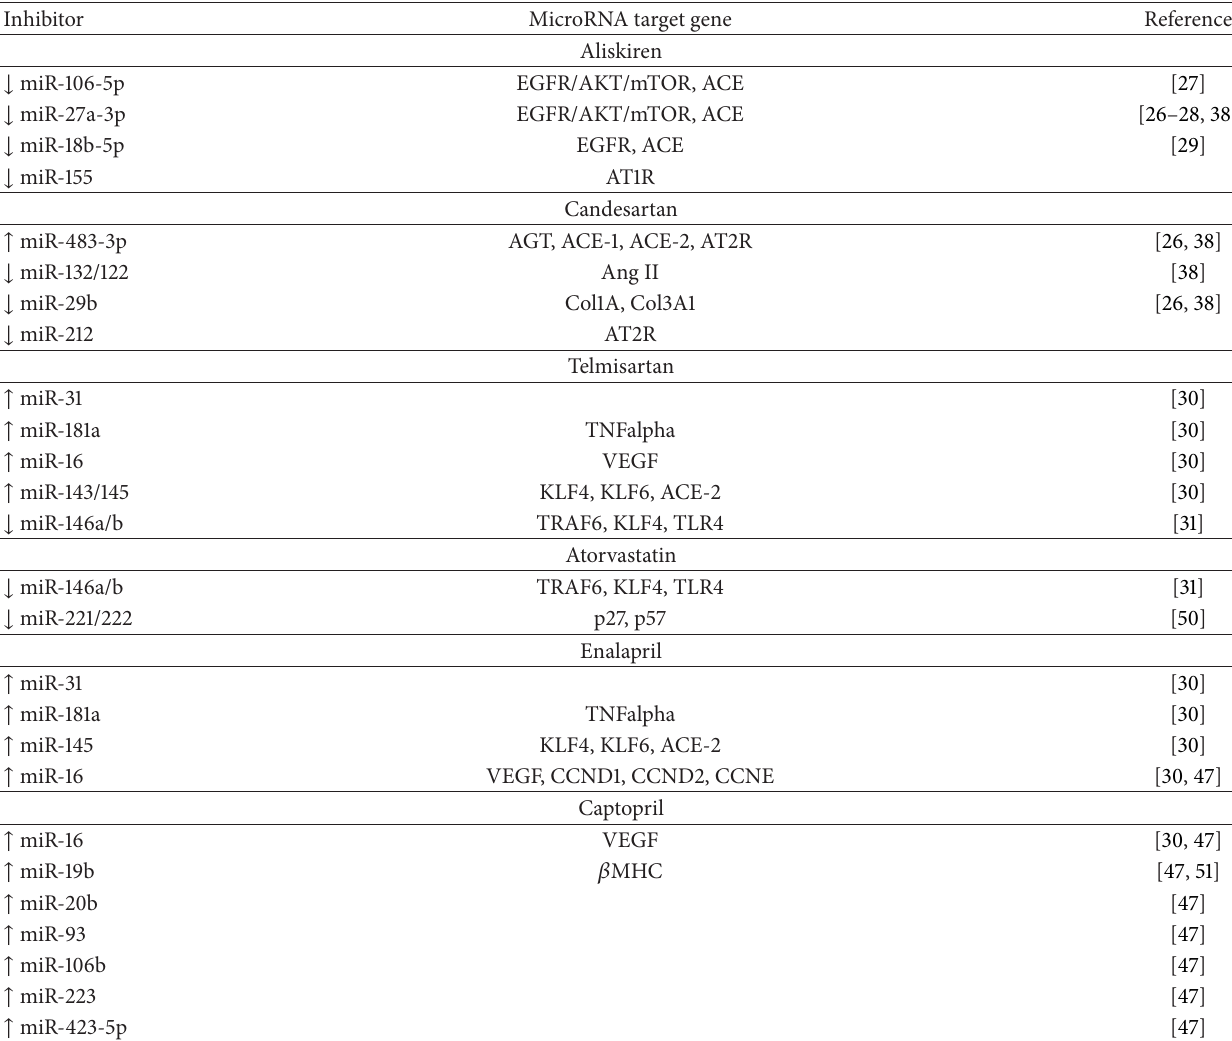
Table 2: MicroRNAs affected by RAAS